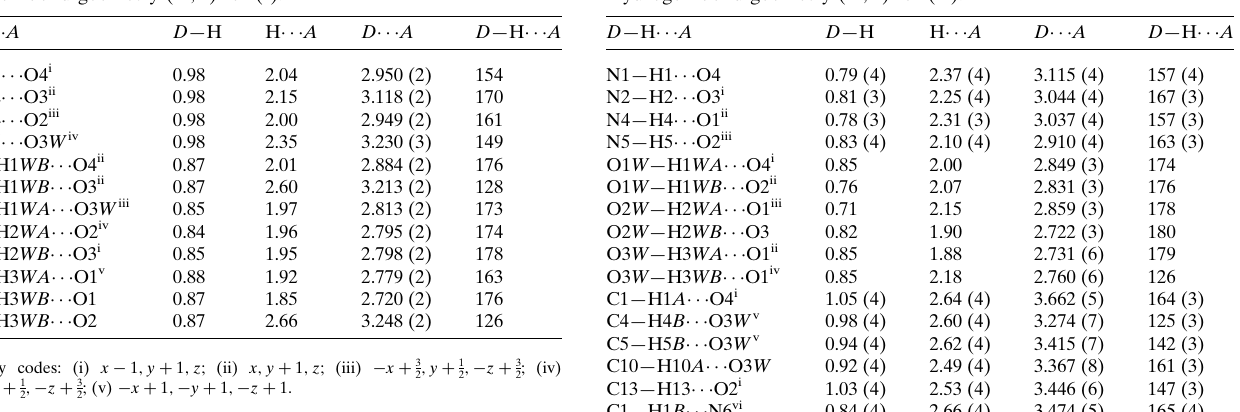
Table 3 Hydrogen-bond geometry (A˚ , (cid:3) ) for (II).